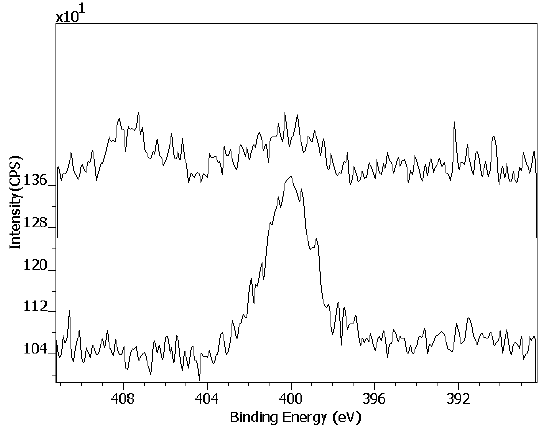
Figure 3: N1s peaks for the DCSBD atmospheric plasma-treated polypropylene in air (top) and in nitrogen